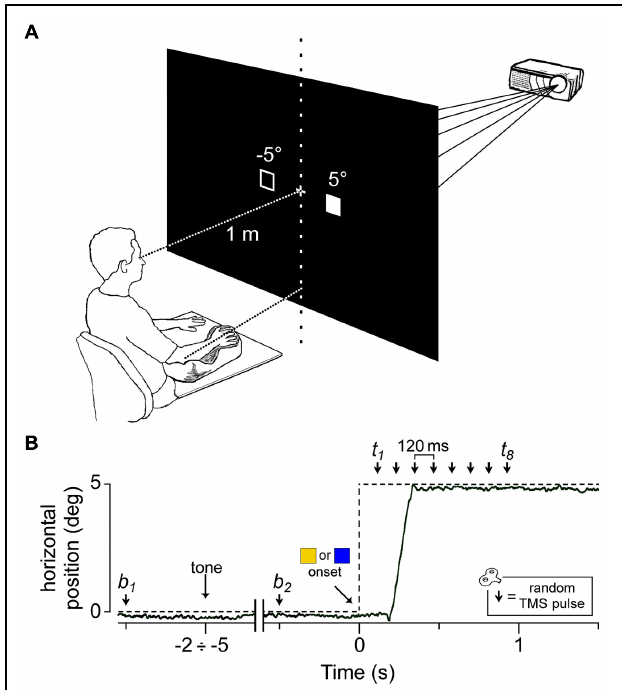
FIGURE 1 | Experimental setup and protocol. (A) Visual stimuli were rear-projected on a wide-tangent black screen placed 1 m in front of the subject. The filled square represents the actual location of the ‘go’/’no-go’ cue, while the empty square indicates the other possible position. The head was immobilized using a chin rest and a head-support device (not shown). Notice the arm-hand posture imposed on the subject with respect to the central vertical meridian (see text). (B) An electrooculography (EOG) recording (solid line) during a representative saccadic response in a ‘go’ trial. The dashed line indicates the time course of the visual stimulation. The peripheral cue ( (cid:2) or (cid:2) ) appeared at a variable time interval of 2–5 s after a warning tone. A single pulse of Transcranial magnetic stimulation (TMS) was randomly delivered either before cue onset (at b 1 or b 2 ) or at one of eight equally spaced time delays between 120 ms and 960 ms ( t 1 – t 8